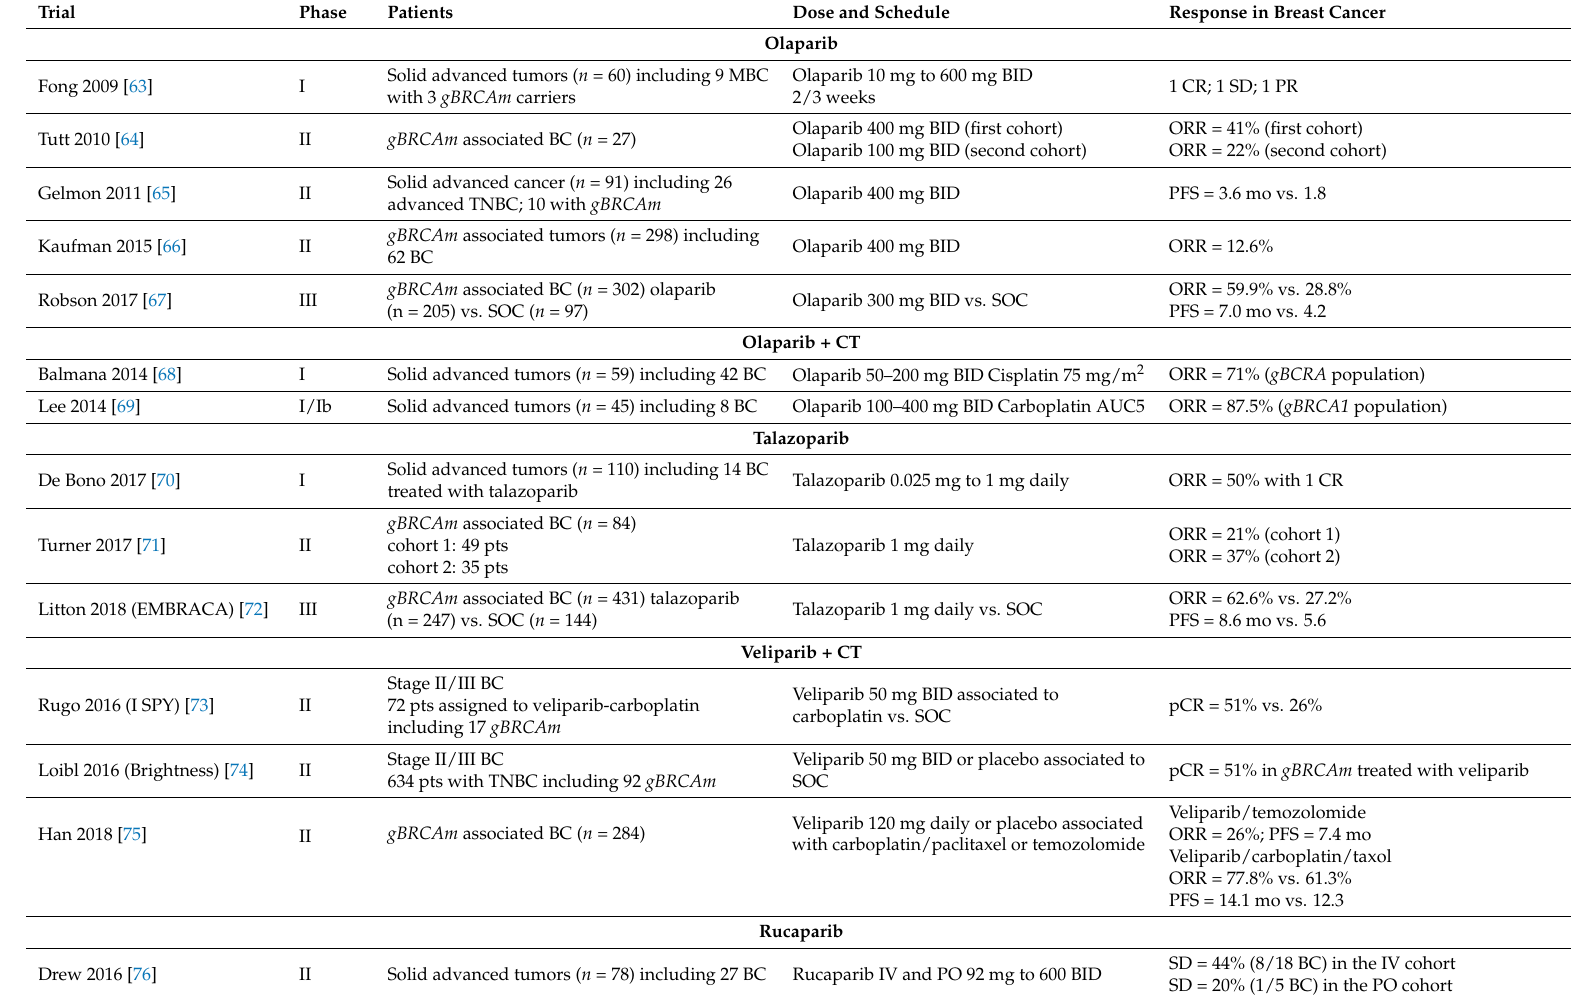
Table 2. BRCA1/2 -associated breast cancer and PARP